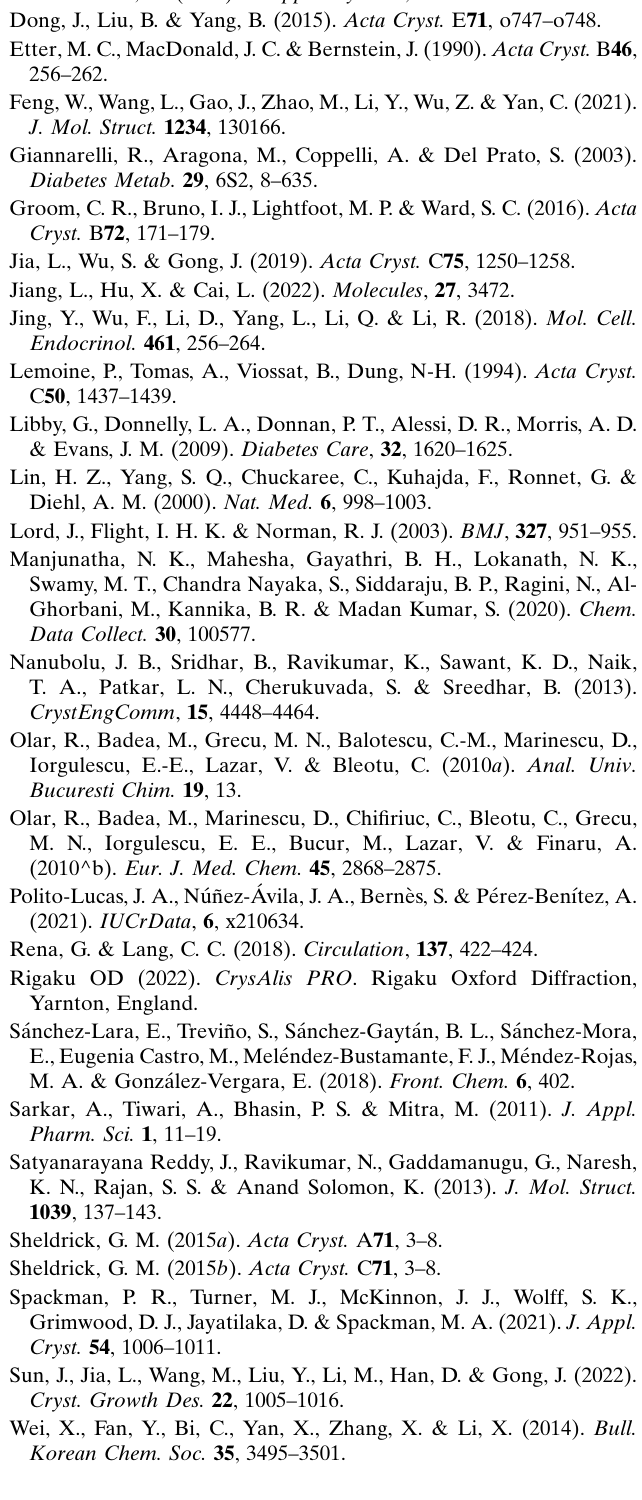
Table 3 Experimental details. Crystal data Chemical